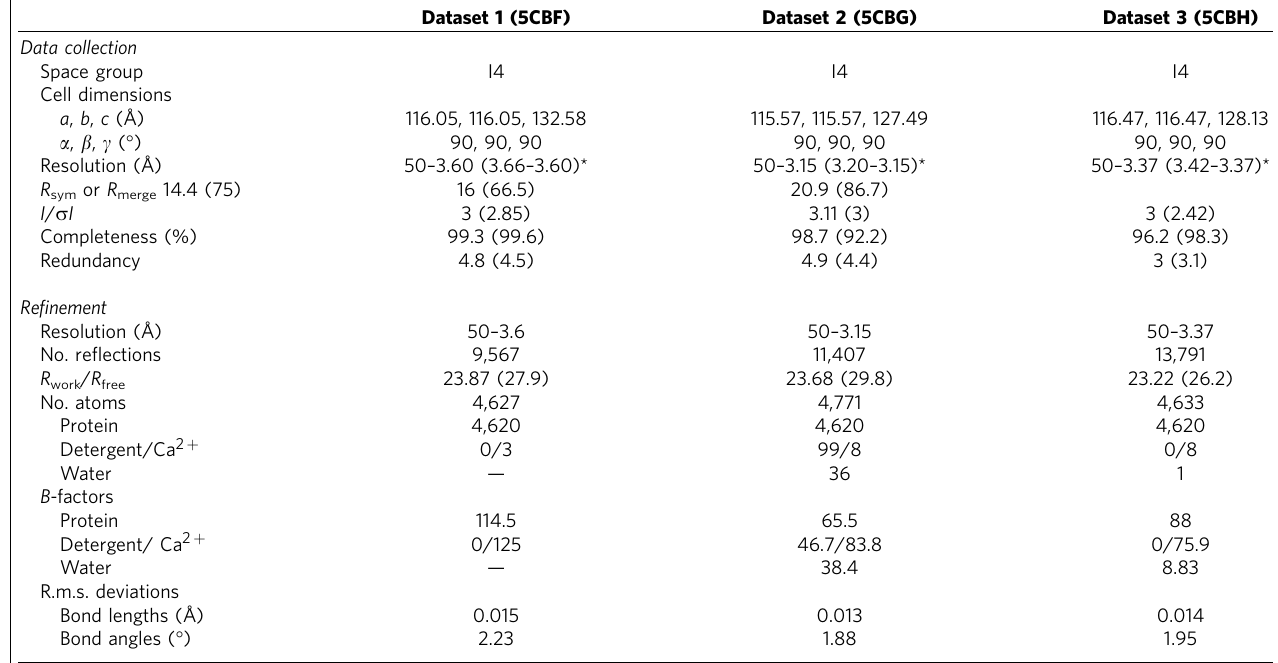
Table 1 | Data collection and refinement